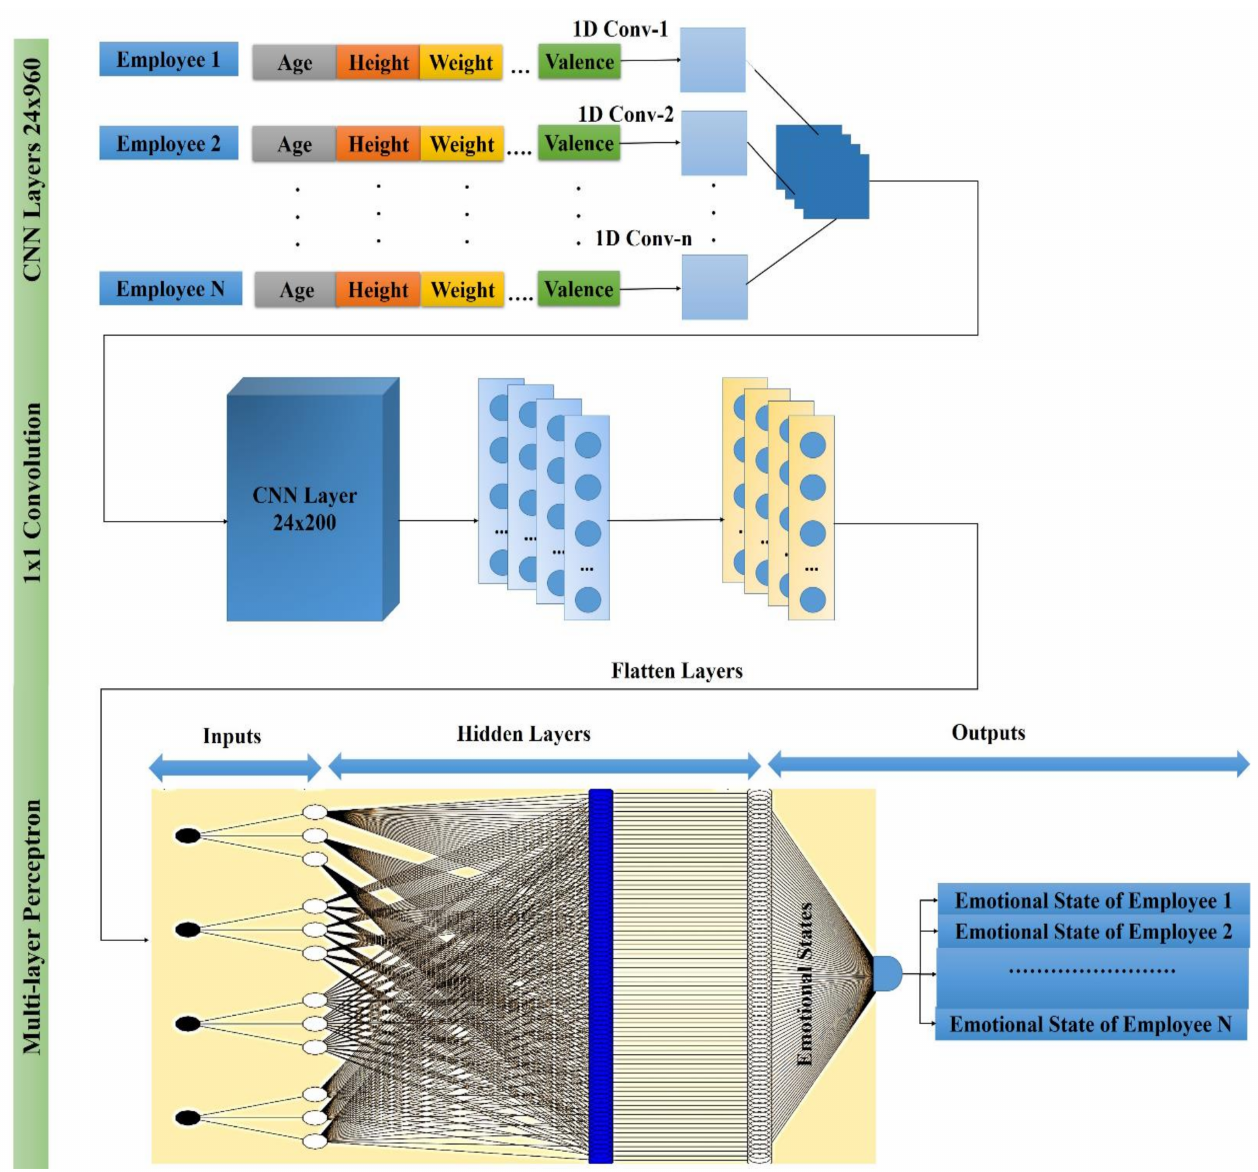
Figure 2. Proposed model for emotional state detection based on the one-dimensional convolutional neural network